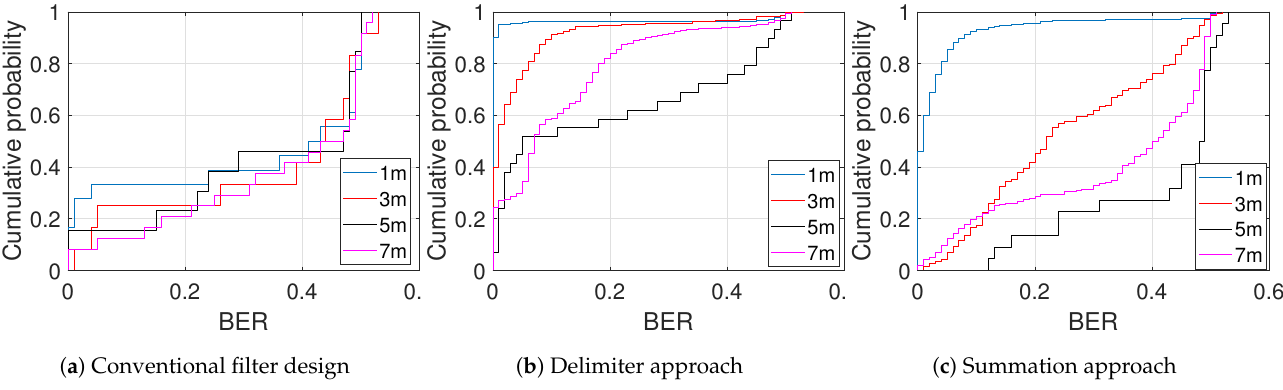
Figure 17. Cumulative probability distribution for various filter schemes: mean-based decoding at 100